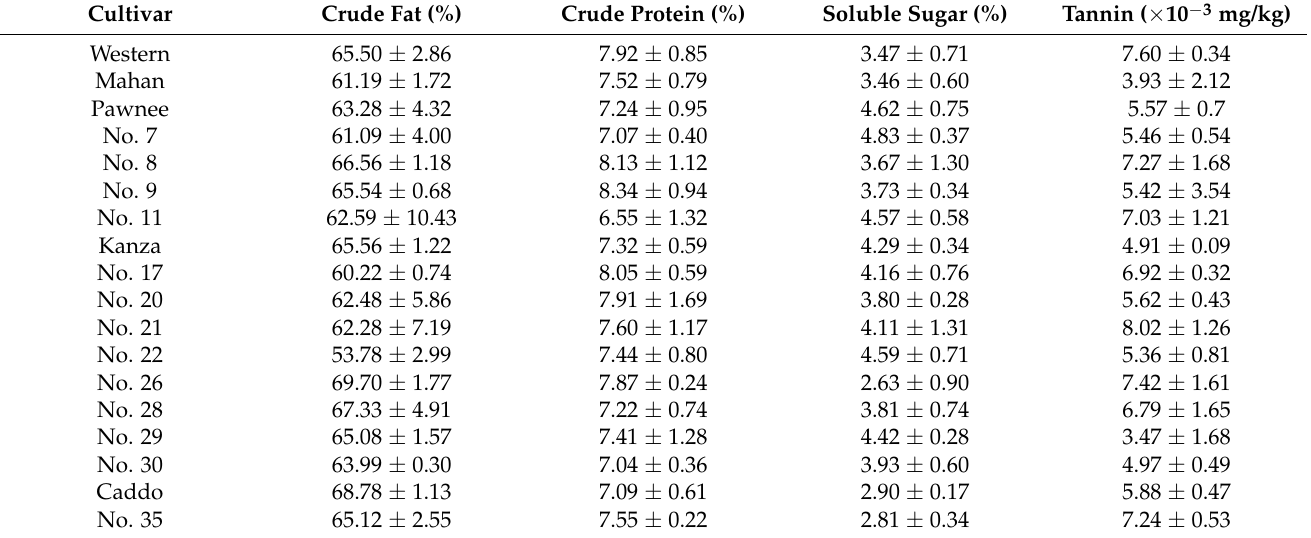
Table 2. Chemical composition of the pecan kernels (dry